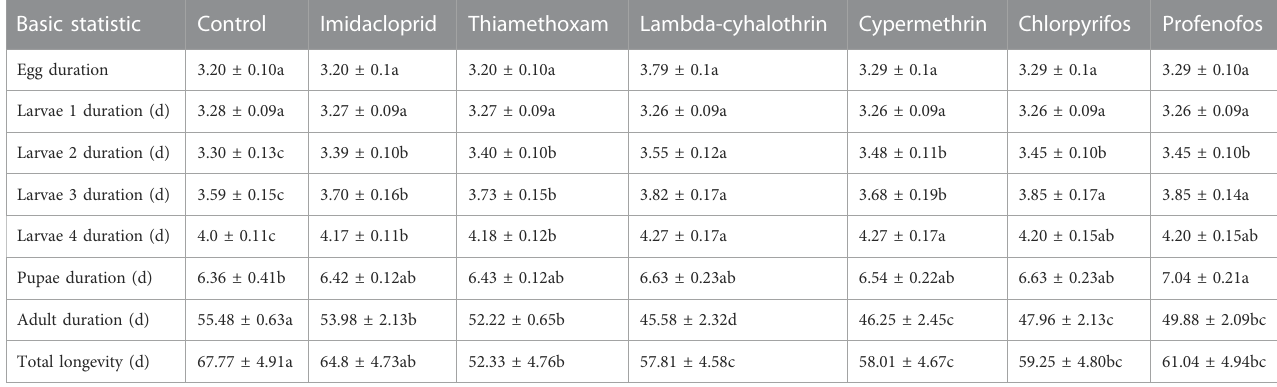
TABLE 1 Means (days ±SE) developmental time of the different life stages of Coccinella septempunctata F1 generation. Basic